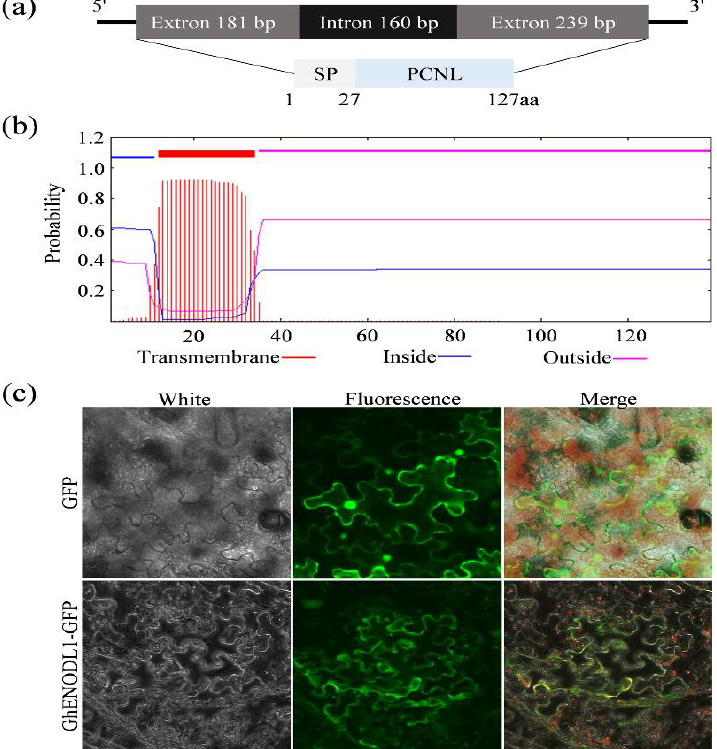
Figure 3. Characterization of GhENODL6 . ( a ) Schematic structure of GhENODL6 . ( b ) Prediction of the transmembrane helix in GhENODL6 protein. ( c ) Subcellular localization of GFP alone or GhENODL6-GFP fusion in tobacco leaves transiently transformed by Agrobacterium infiltration. The green fluorescence was monitored using a confocal laser scanning microscope.